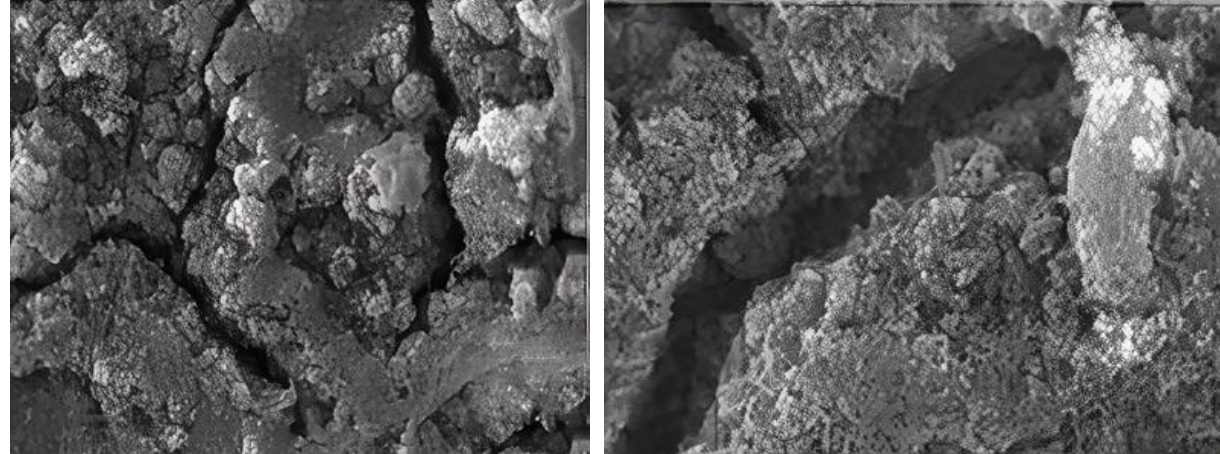
Figure 9. Photographs of FESEM TiO 2 layer at 5 µm (left) and 10 µm (right) at 500 °C.